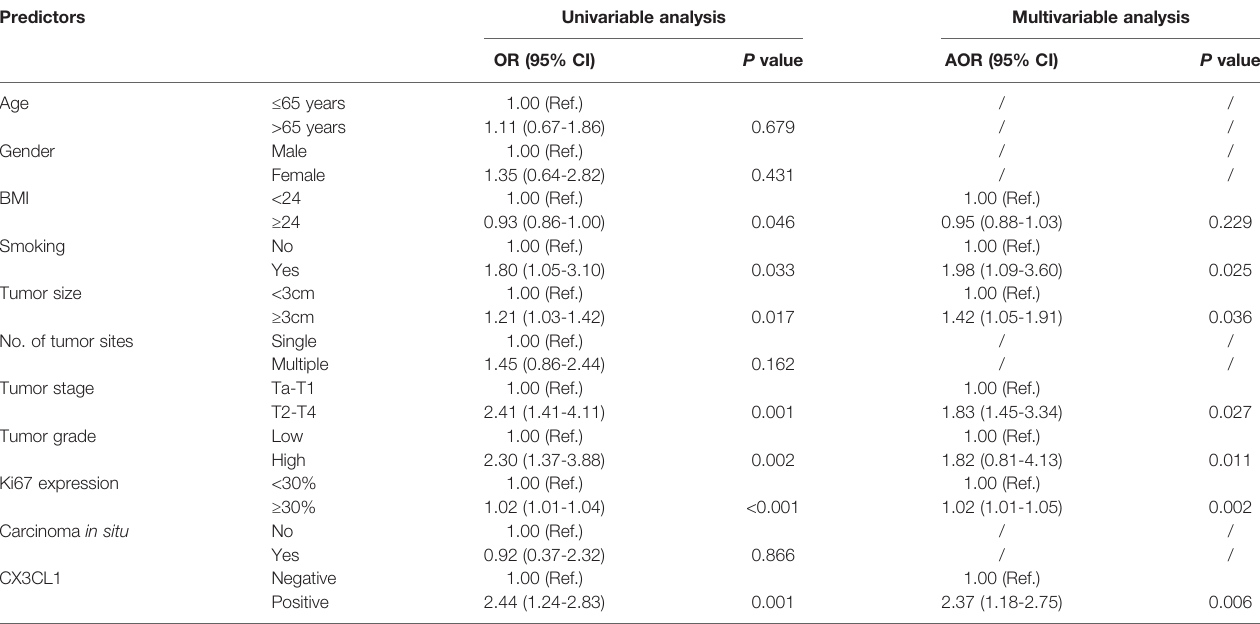
TABLE 2 | Univariable and multivariable logistic regression analyses on tumor recurrence.